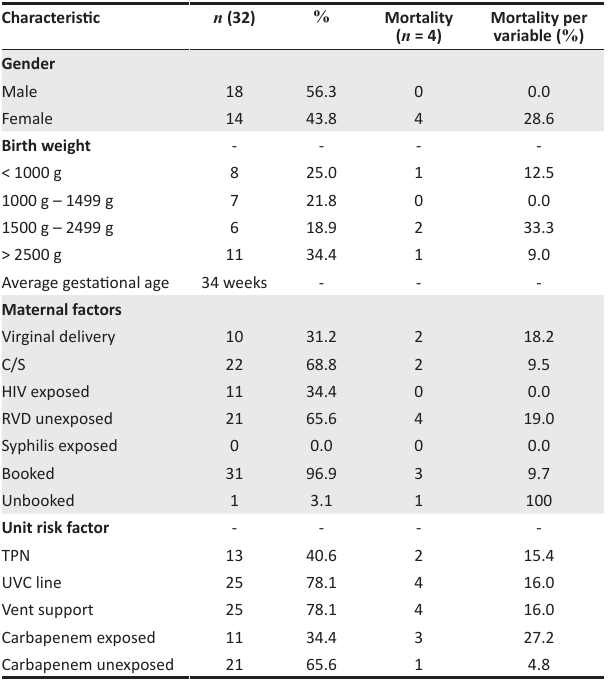
TABLE 1: Characteristics and demographic for Carbapenem-resistant Enterobacteriaceae -infected neonate.